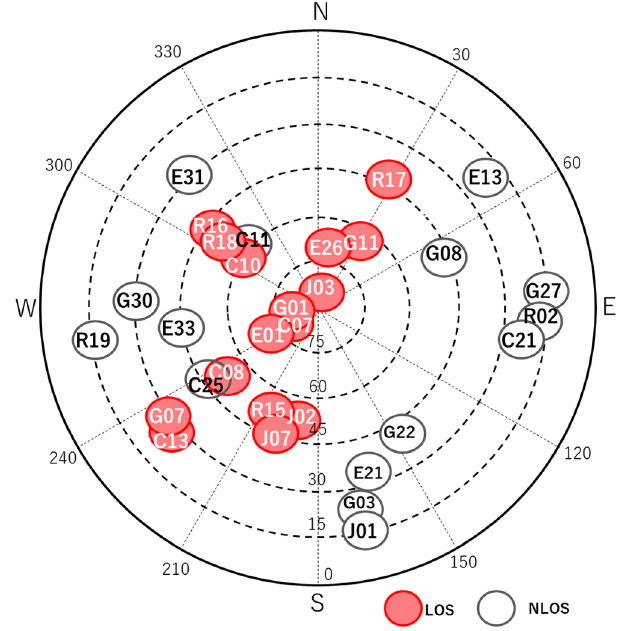
Figure 3. Sky plots of all satellites and their conditions (8:25:00, 462,300 s).